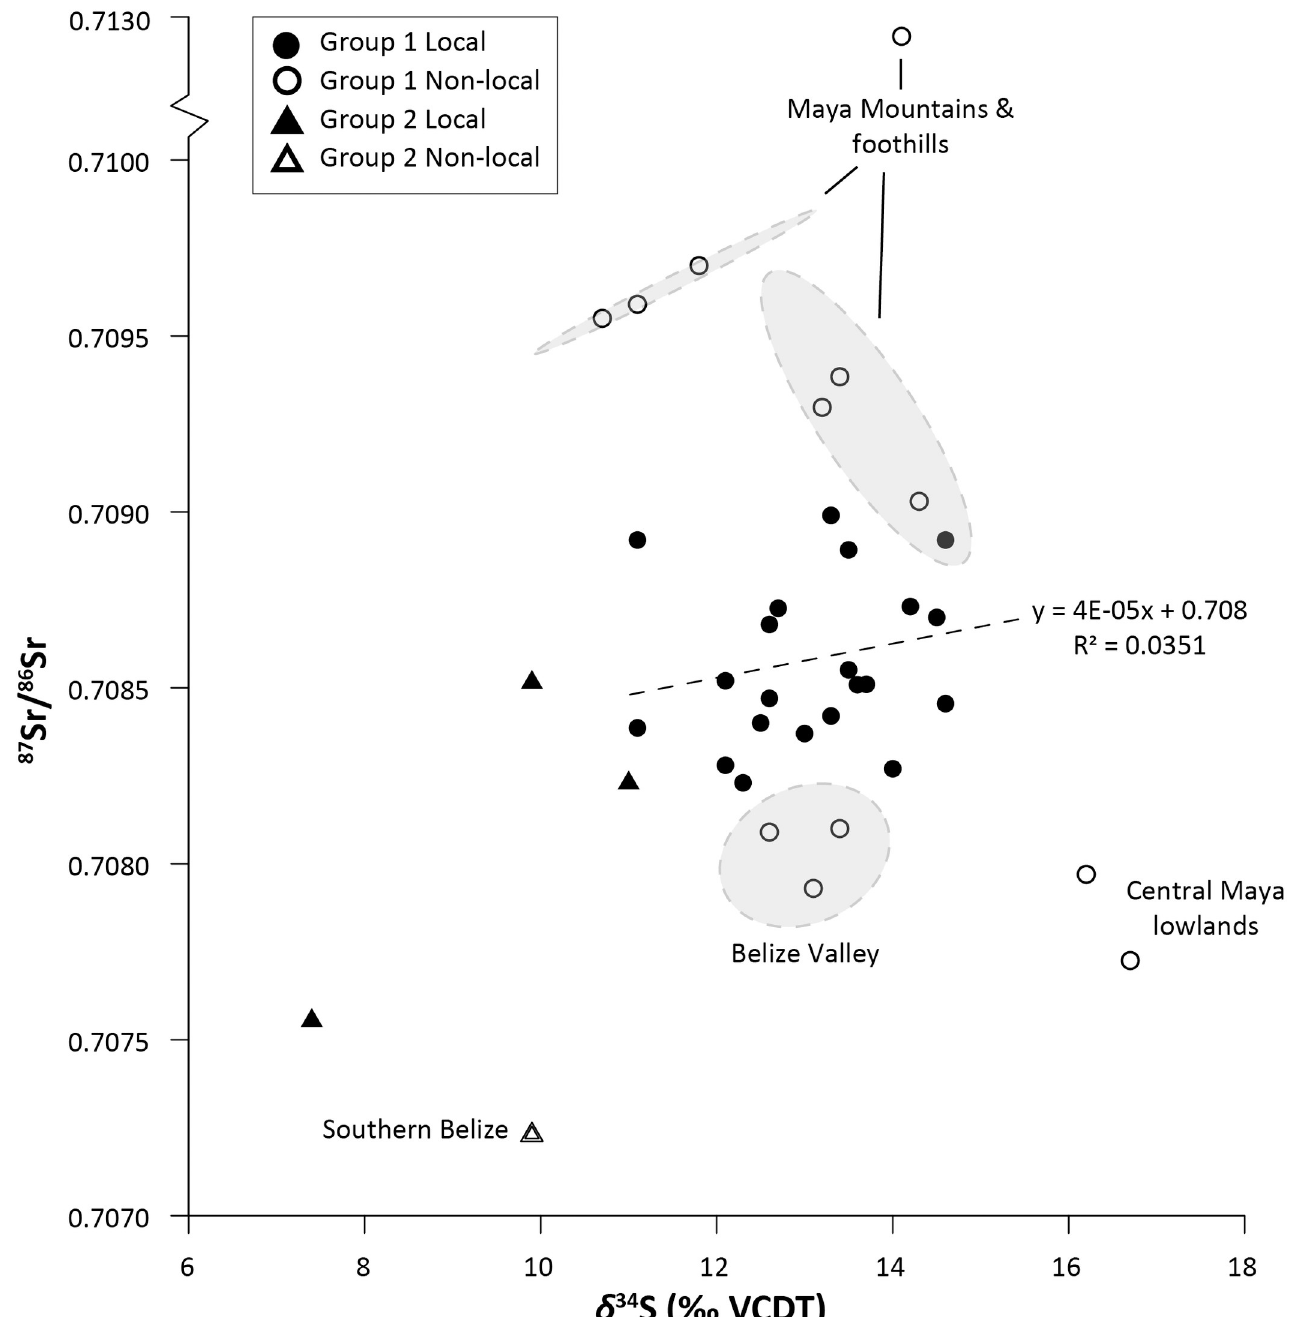
Fig 8. Comparison of human 87 Sr/ 86 Sr and δ 34 S values for the Eastern Maya lowlands. Correlations between 87 Sr/ 86 Sr and δ 34 S and regression lines were calculated only for individuals only identified as “local” in previous strontium-based studies from sample sizes n > 5 (Group 1). Possible origins for non-local individuals are proposed based on published 87 Sr/ 86 Sr data (see S2